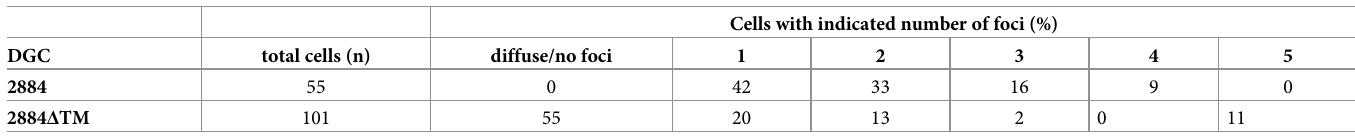
Images from Fig 3 were analyzed with Fiji ImageJ software to assess localization of indicated proteins. Foci were counted per cell and populations consisting of different localization patterns were placed into the indicated categories and population percentages were reported.